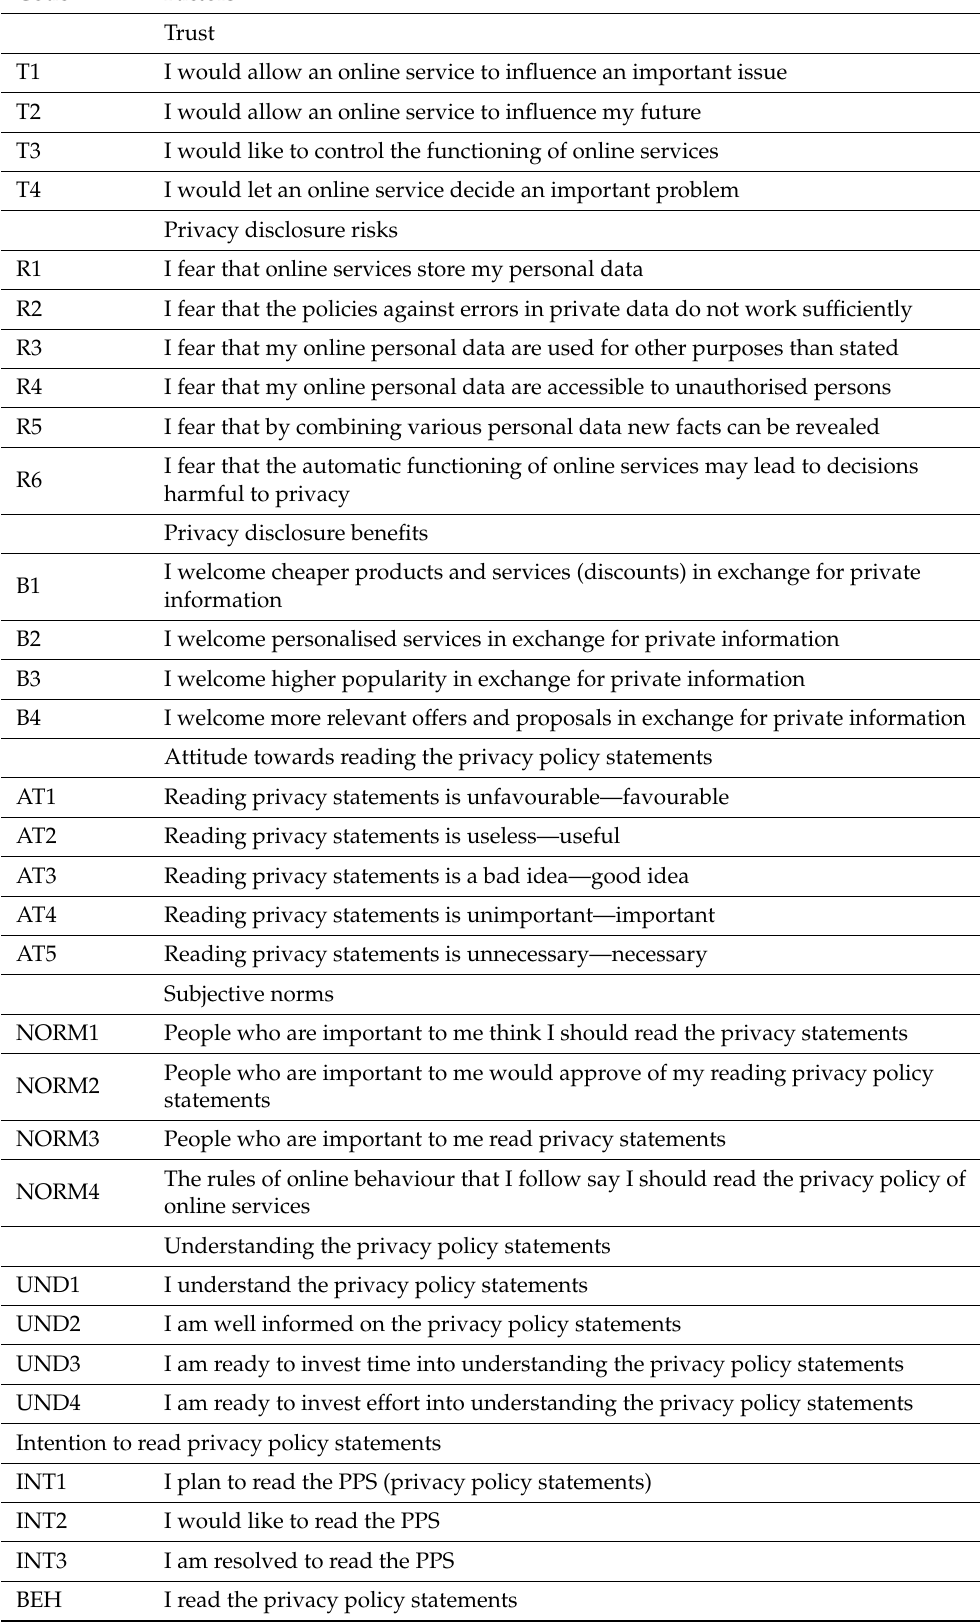
Table 1. Factors and